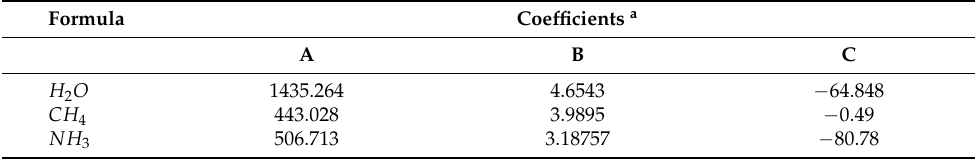
Table 3. Antoine coefficients of utilized